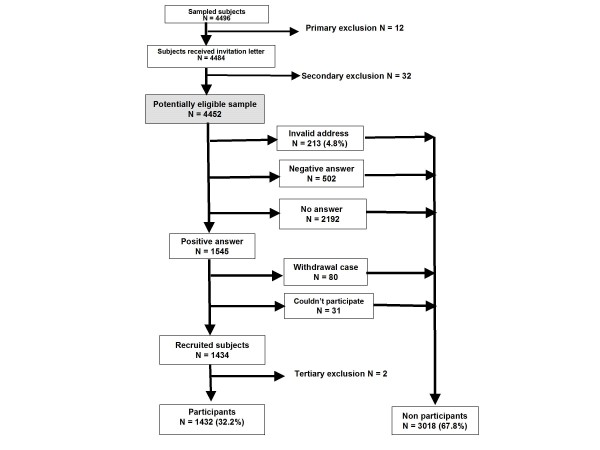
The ORISCAV-LUX subject's recruitment flowchart. Primary exclusion before invitation includes 12 addresses of institutionalized subjects. Secondary exclusion after sending the invitation letter includes 32 subjects (pregnant women, mentally ill and deceased cases). Tertiary exclusion from the database after recruitment (> 69 years old).